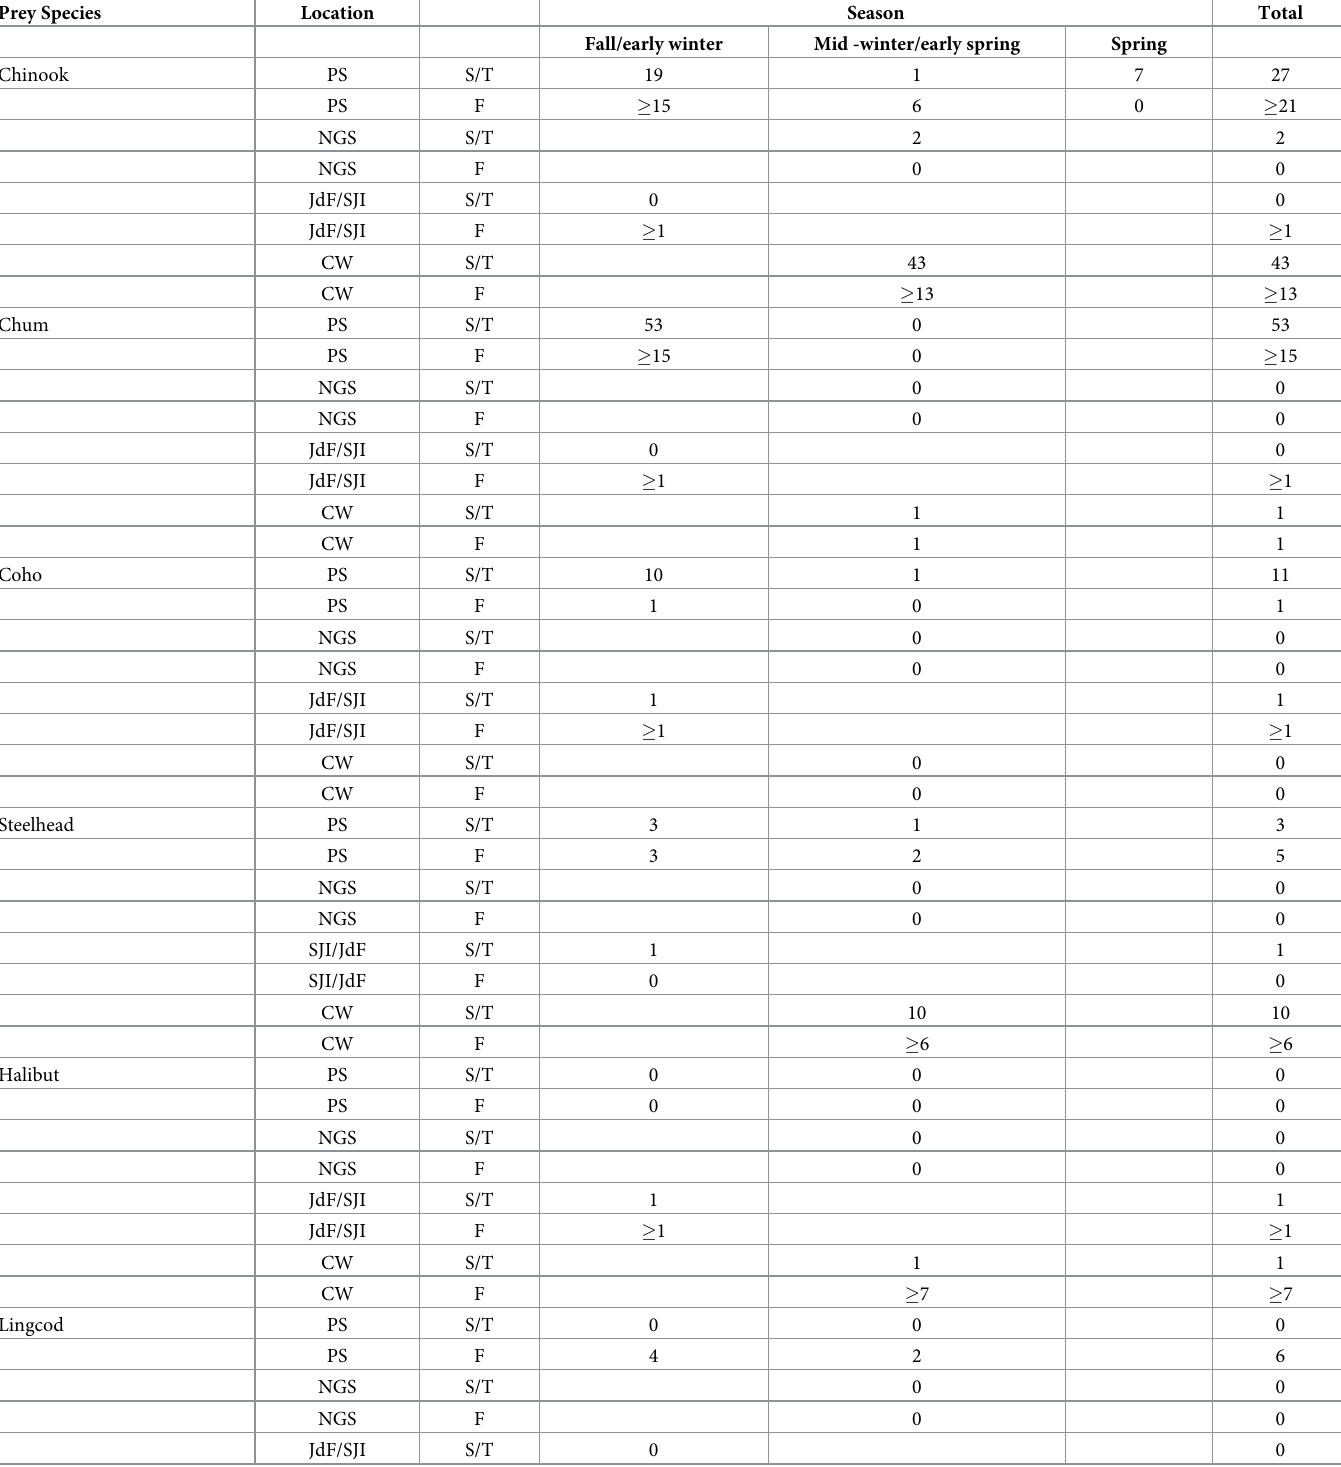
Table 1. Total number of Southern Resident killer whale prey identified to species from Scale (S) or Tissue (T), and Fecal (F) analyses (excluding species with < 1% in weighted averages) by season in Puget Sound (PS), Juan de Fuca Strait/San Juan Islands (JdF/SJI), Northern Georgia Strait (NGS), and outer Coast Waters